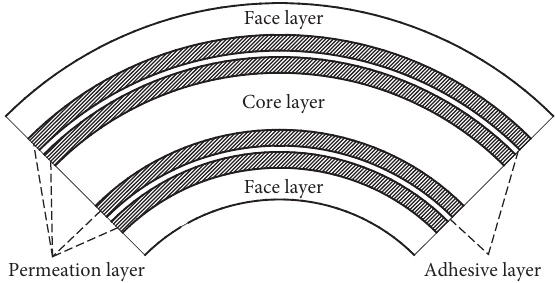
Figure 1: Permeation effect in the sandwich